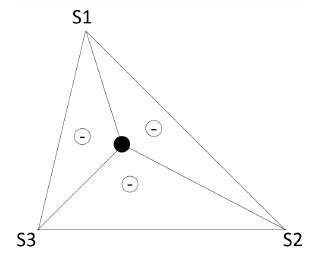
Figure 3. Triangulation method concept. Figure 3. Method of trilateration between nodes S1, S2,